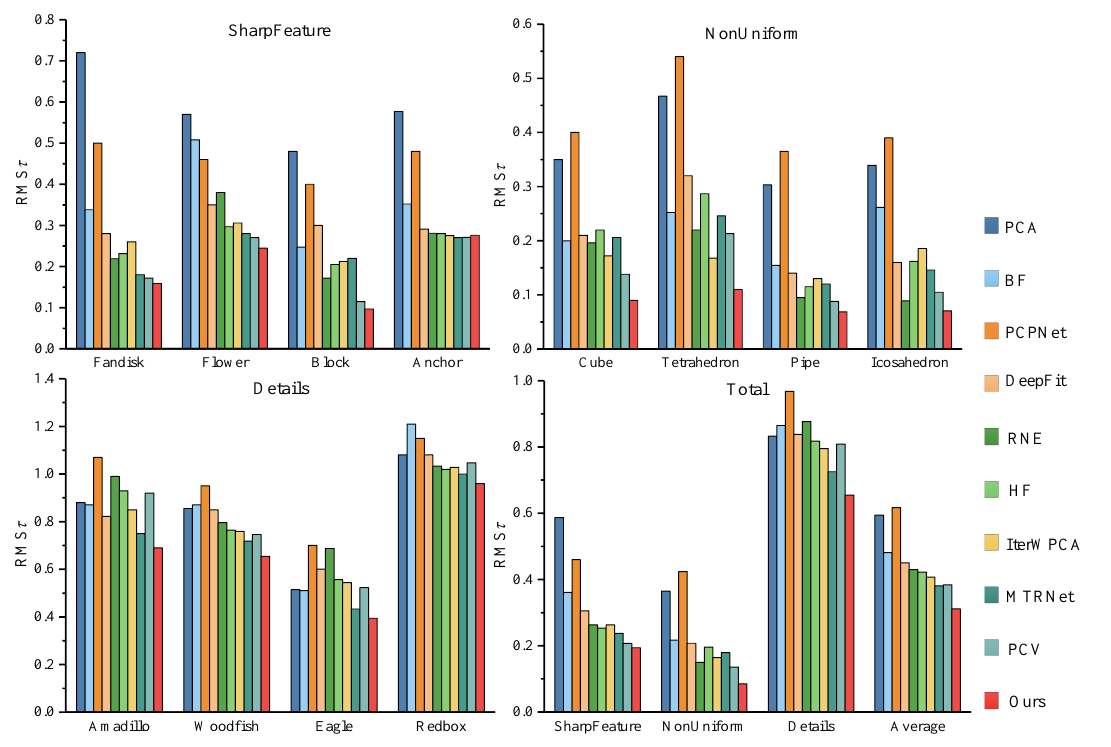
Figure 6. The RMS τ estimated by various methods, where the first three respectively represent the angular error of sharp feature models, non-uniform sampling models, and detail models; the comparison of the comprehensive performance of each algorithm in each category is demonstrated at the end, in which the average errors of each category and all models are included.